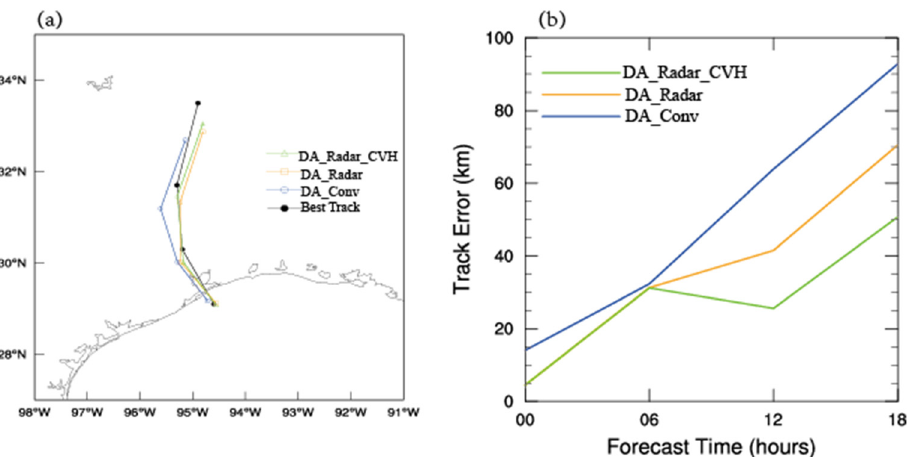
Figure 12. ( a ) track, ( b ) track error from 0600 UTC, 13 September to 0000 UTC, 14 September.